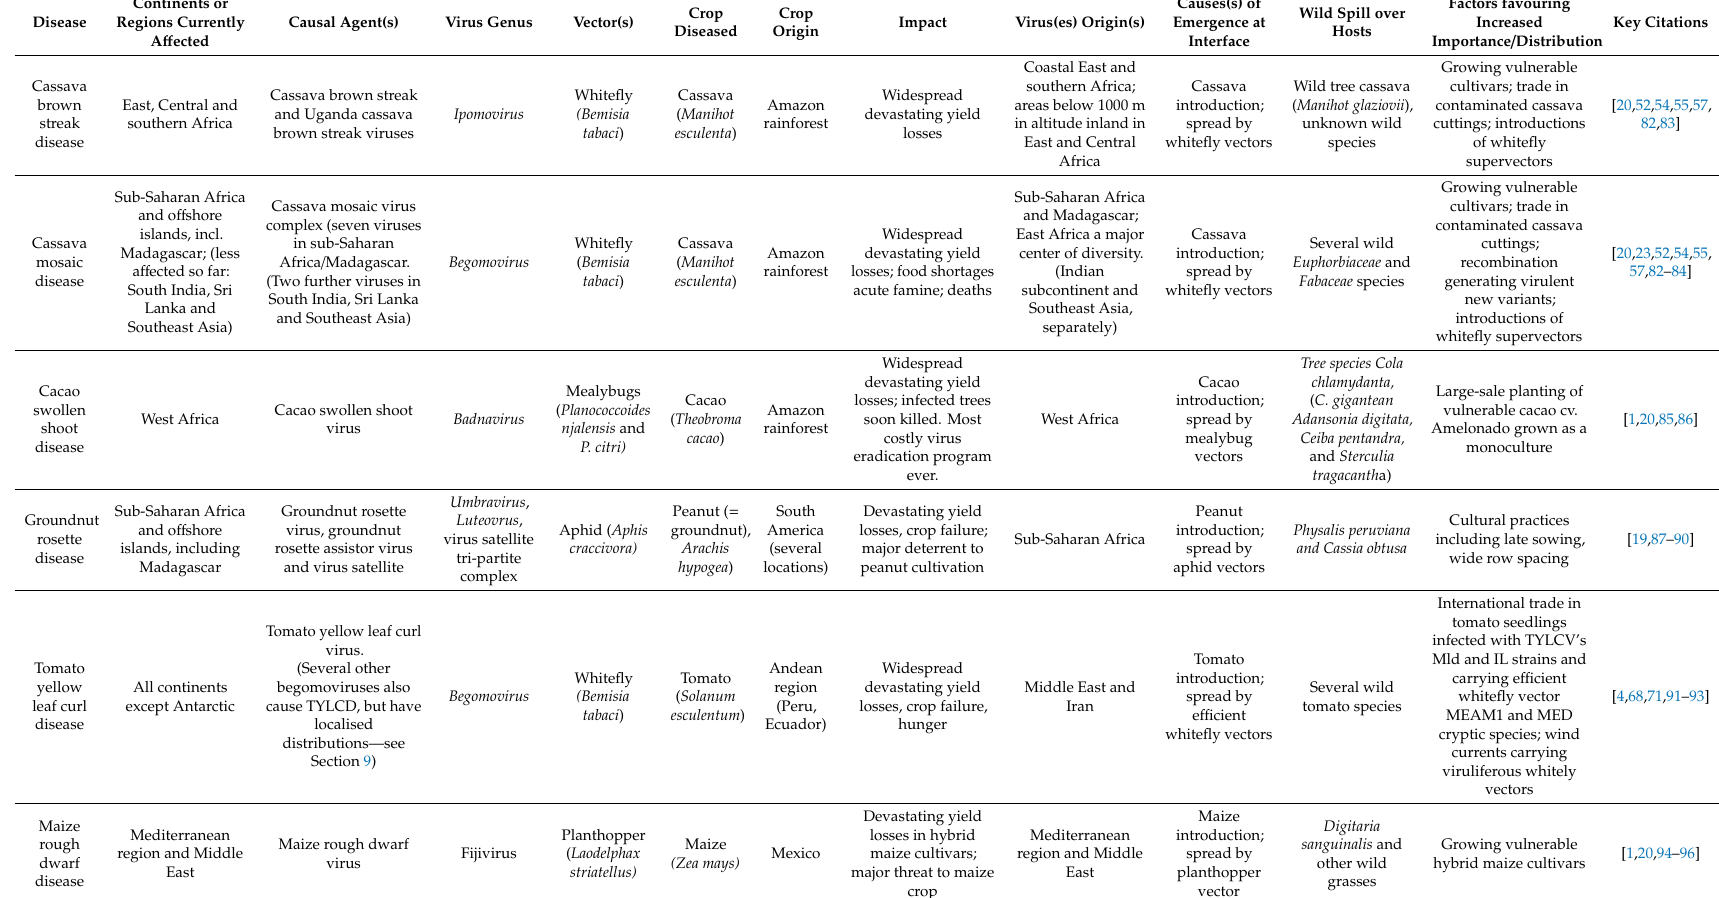
Table 1. Nine examples of virus disease pandemics or major epidemics of critical importance for global food security initiated by encounters between indigenous viruses and introduced